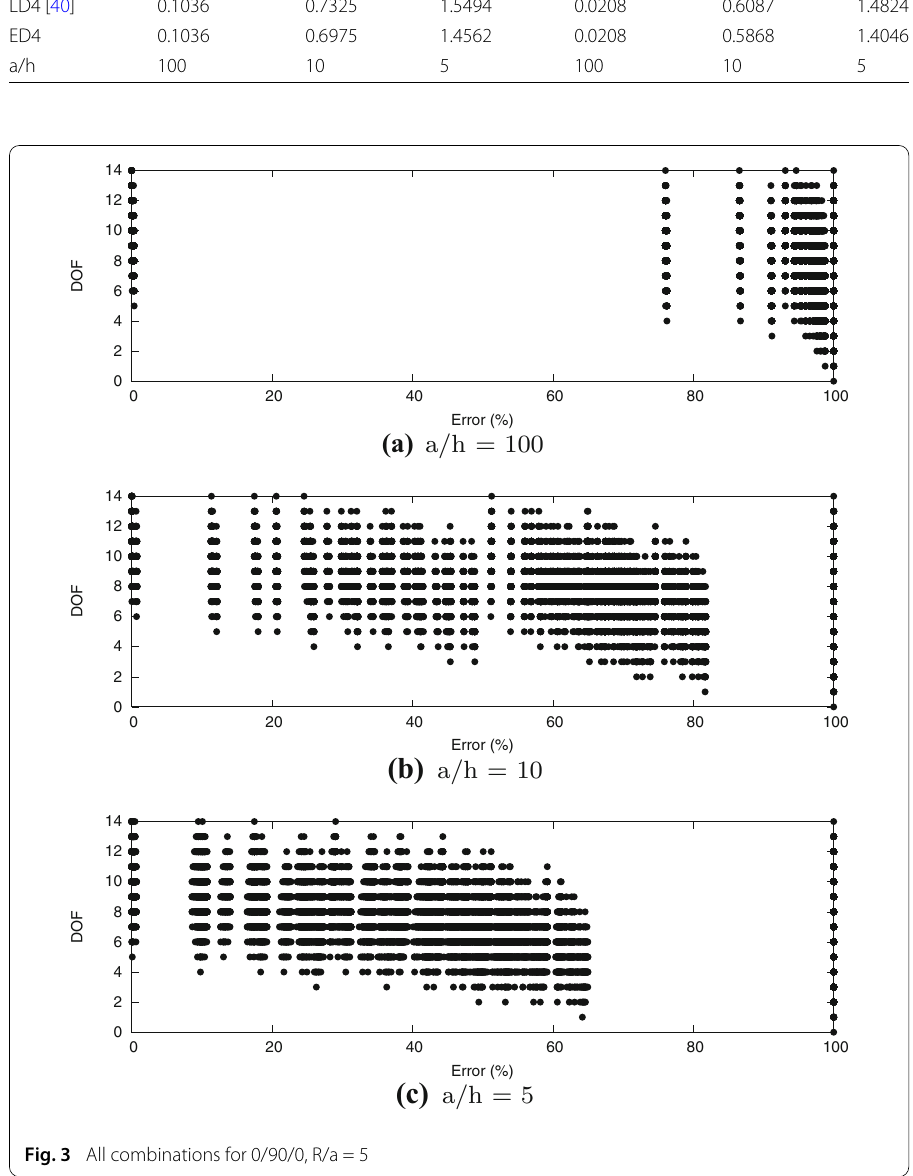
Fig. 3 All combinations for 0/90/0, R/a =